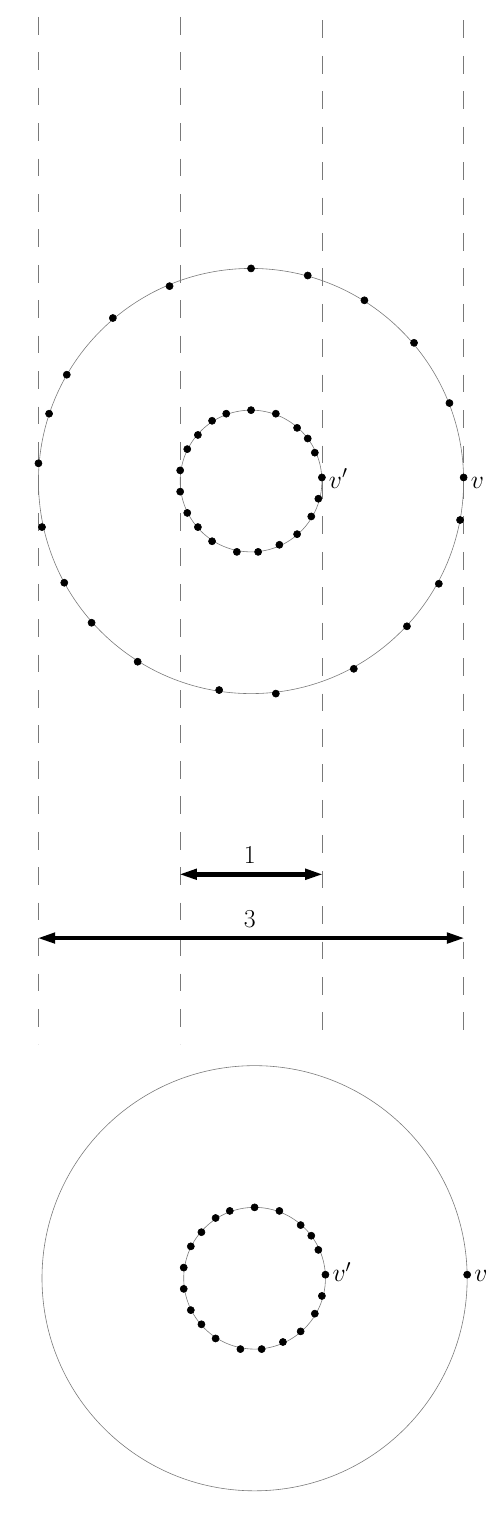
Figure 7 . The graph G we omit the edges of the